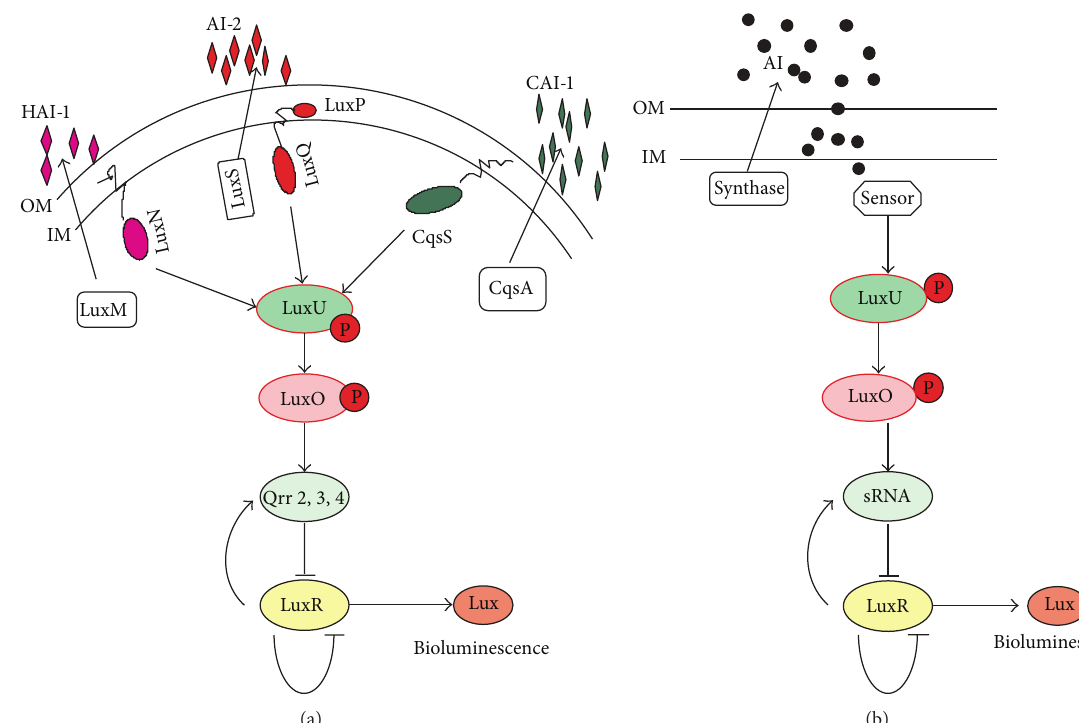
Figure 1: Schematic diagram showing the gene regulation mediated by sRNA with a negative feedback loop. (a) Original model; (b) abstract